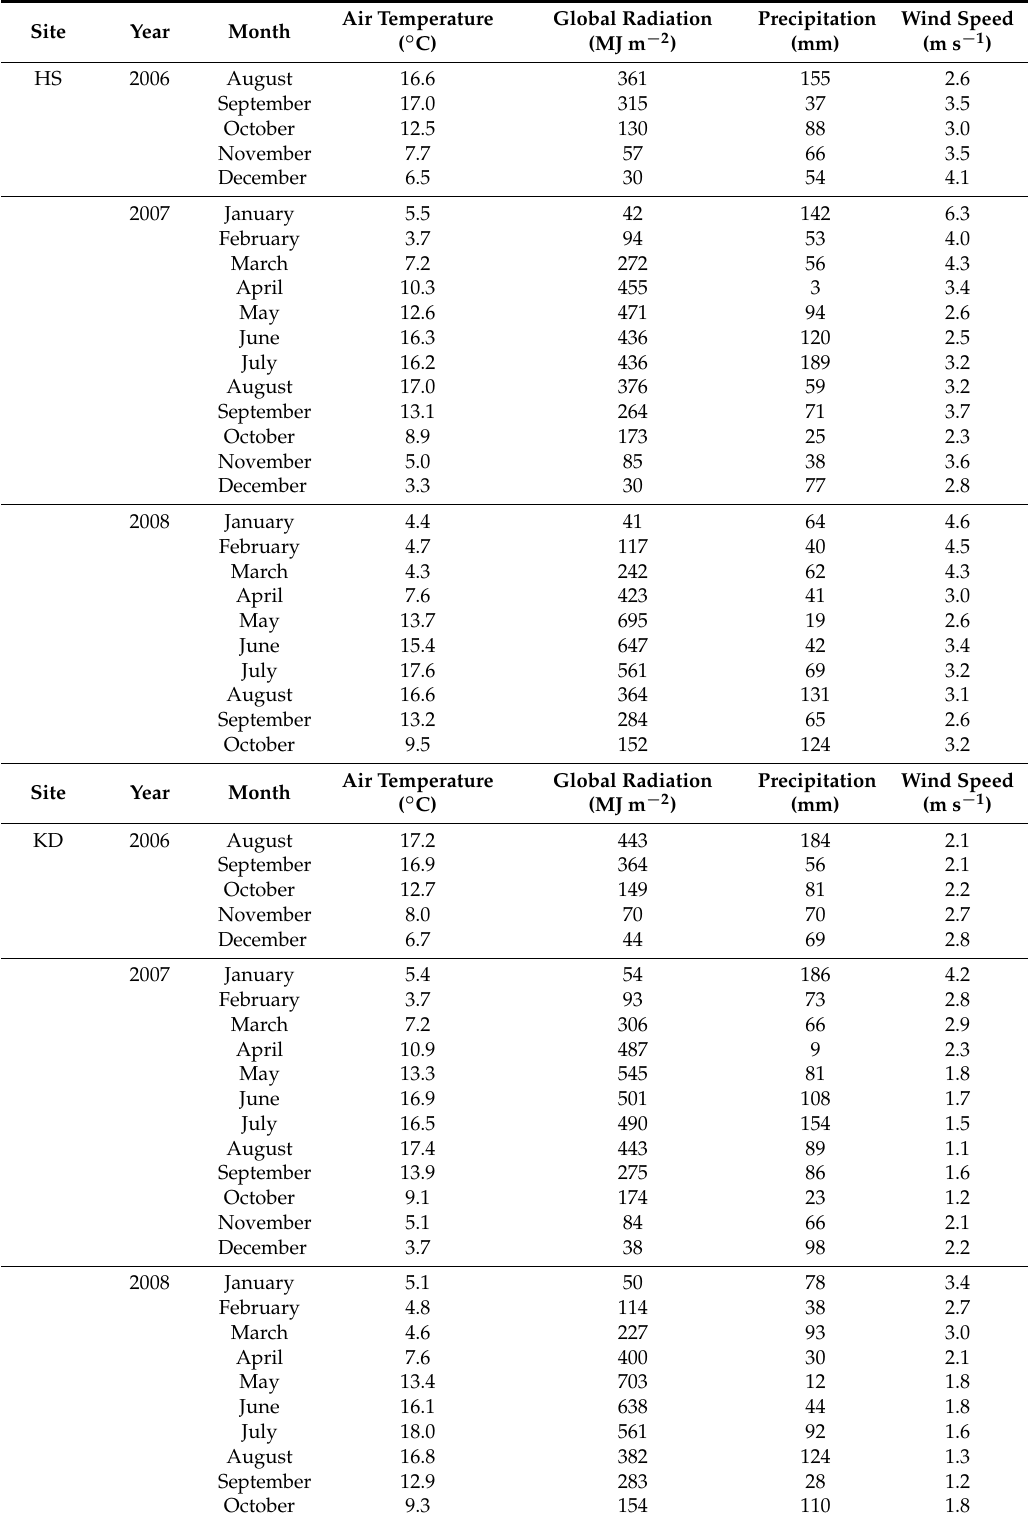
Table 1. Monthly average air temperature, wind speed, accumulated global radiation and accumulated precipitation given for the experimental periods and both sites Hohenschulen (HS) and Karkendamm